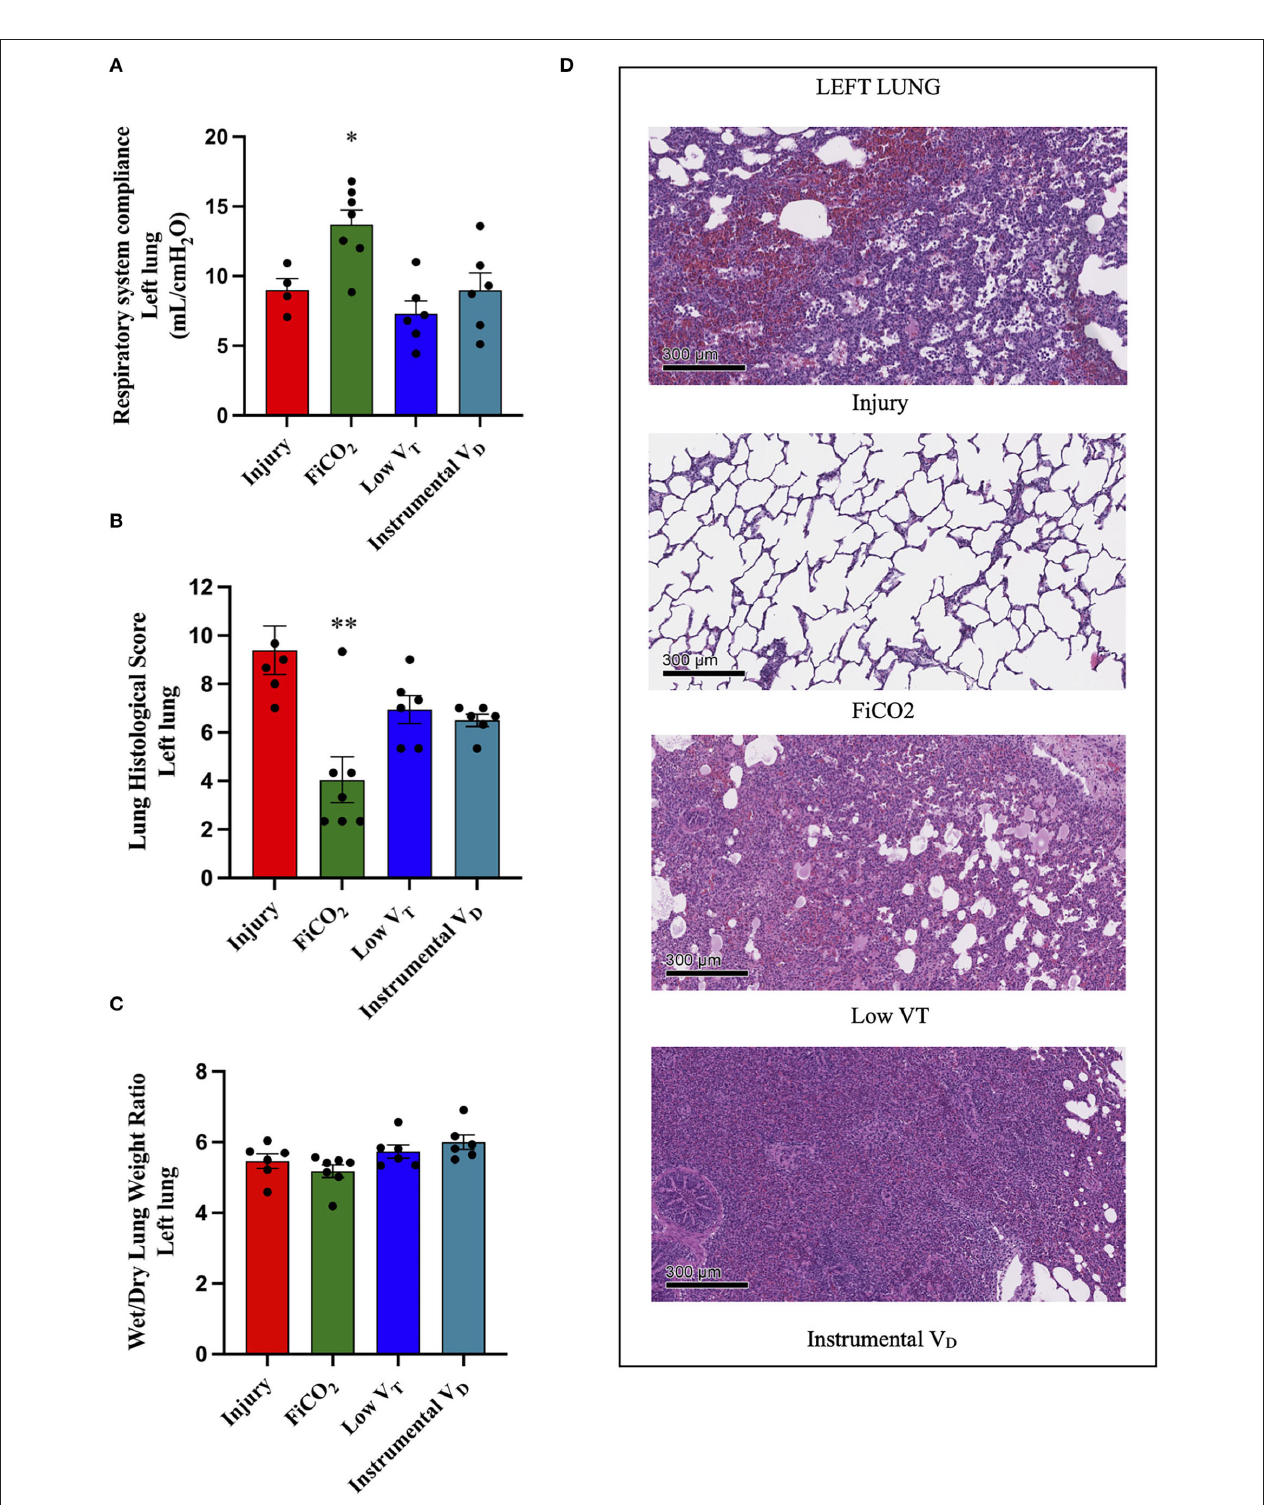
FIGURE 3 | Left lung injury. Left-side respiratory system compliance at the end of the experiment (A) . Histological score of left lungs from each study group (B) . Wet-to-dry of left lungs (C) . Microscopic appearance of the lungs at the end of the experiment (D) . Representative microphotographs of the left ligated lungs from the four study groups (H&E, original magnification 100 × ). Data are expressed as scatter dot plots with mean ± SEM. Comparisons are obtained with ordinary one-way ANOVA or Kruskal–Wallis test for normally and non-normally distributed values, respectively, followed by Dunnett or Dunn’s multiple comparison test. * p < 0.05, ** p < 0.01 vs. Injury